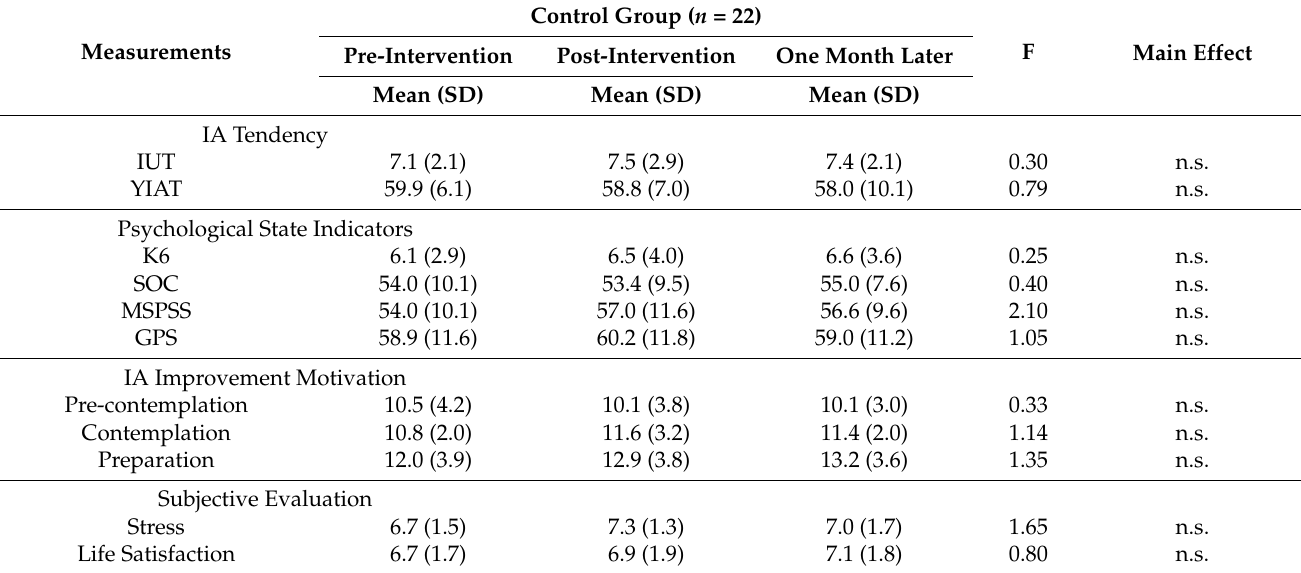
Table 5. Results of Follow-up Effectiveness Evaluation of Control Group ( n =